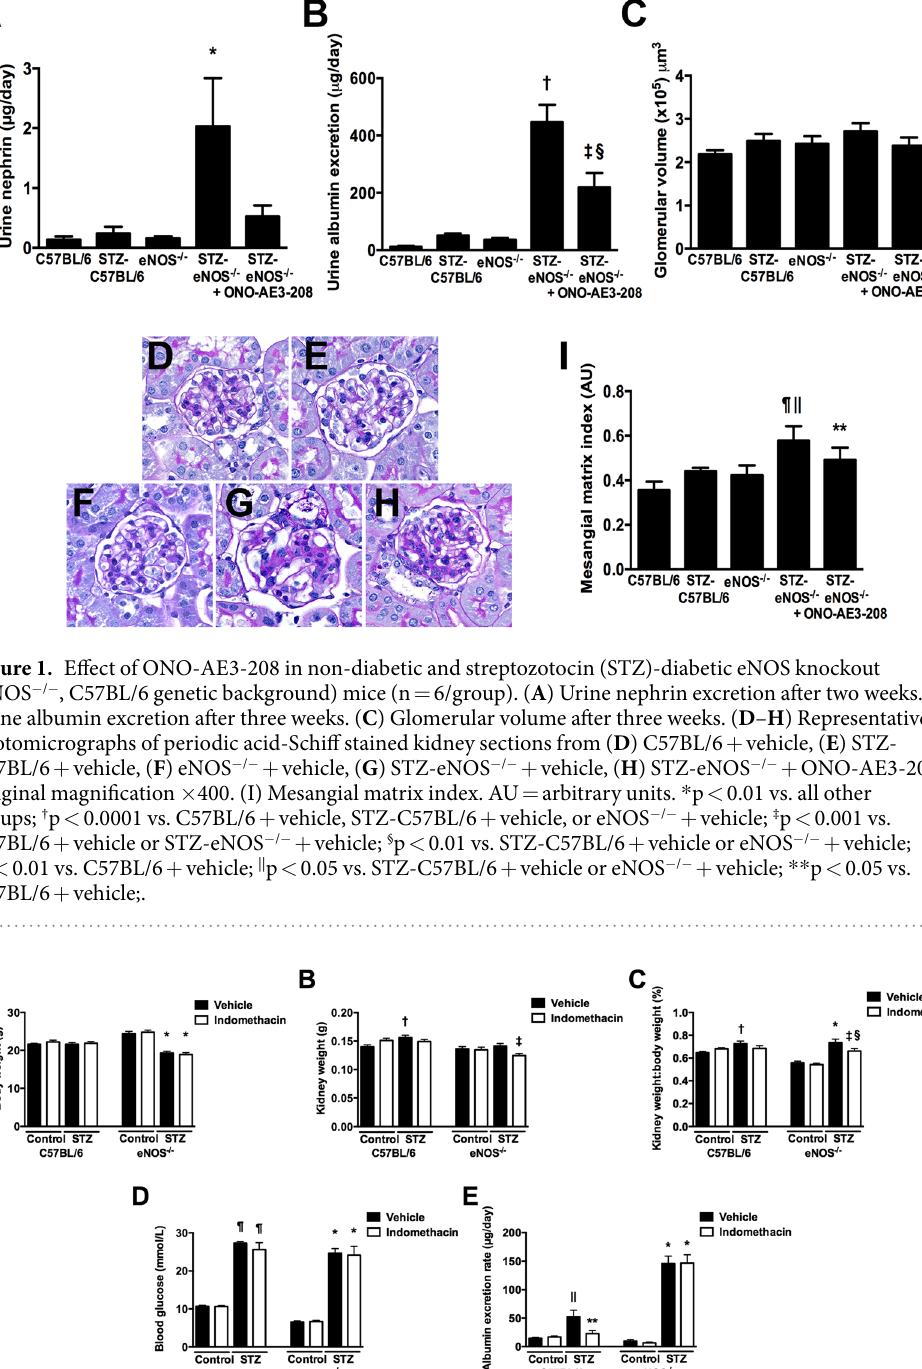
difference in serum creatinine, albuminuria was reduced with both ONO-AE3-208 and captopril (Fig. 3B and C). Histologically, consistent with the marked lowering of blood pressure with ACE inhibition, the kidneys of